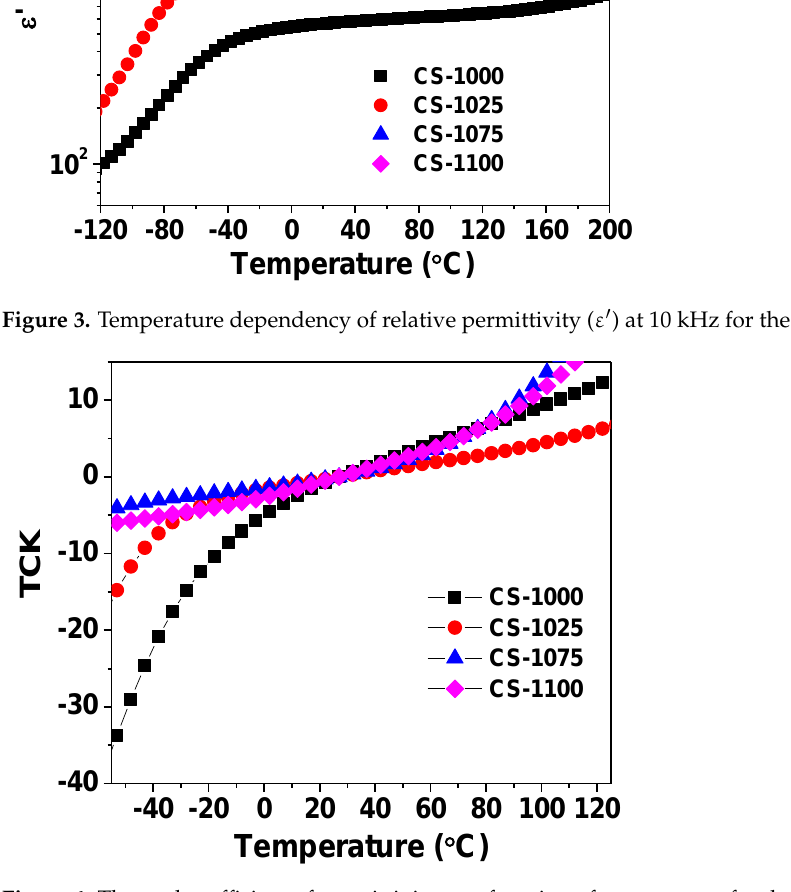
Figure 4. Thermal coefficient of permittivity as a function of temperature for the NSCTO ceramics.